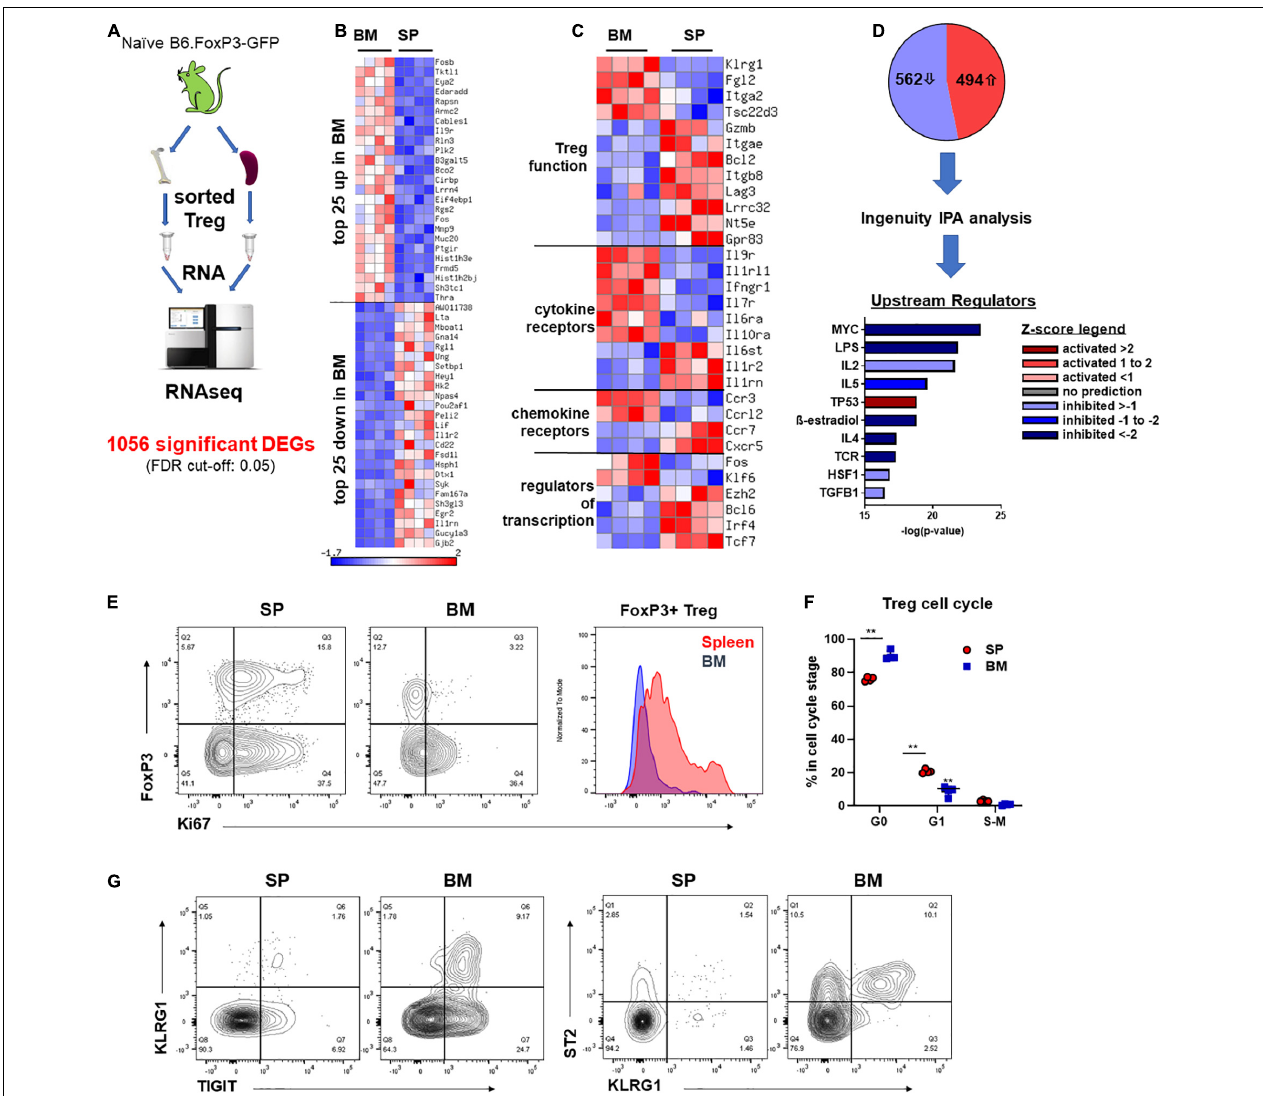
FIGURE 4 | BM-Treg exhibit distinct transcriptional and phenotypic signatures. (A–D) RNAseq analysis of FoxP3 + Treg sort purified from either the BM or SP of 12-week-old naïve B6.FoxP3-GFP mice. (A) Outline of RNAseq analysis strategy. (B) Heatmap showing bulk RNRseq analysis of DEGs in FoxP3 + cells ( n = 3 replicated per tissue). Top 25 upregulated and downregulated DEGs in BM-Treg. (C) Heatmap showing curated analysis of DEGs in BM-Treg. Differential expression of genes associated with Treg activation and function. (D) Ingenuity IPA of likely upstream regulators. (E) Representative flow cytometry analysis of Ki67 expression relative to FoxP3 + expression in CD4 + CD3 + T cells isolated from the SP or BM. Representative histogram of Ki67 expression FoxP3 + CD4 + Treg from the SP or BM. (F) Cell cycle analysis of FoxP3 + Treg isolated from either the BM or SP of naïve B6.FoxP3-GFP mice ( n = 3). (G) Flow cytometry analysis of TIGIT + , KLRG1 + and ST2 + Treg in the SP and BM. RNAseq, RNA sequencing; DEGs, differentially expressed genes; IPA, interpretative phenomenological analysis. Data are shown as mean ± SEM. Statistical significance was determined using an unpaired 2-tailed Mann-Whitney U test (** P <